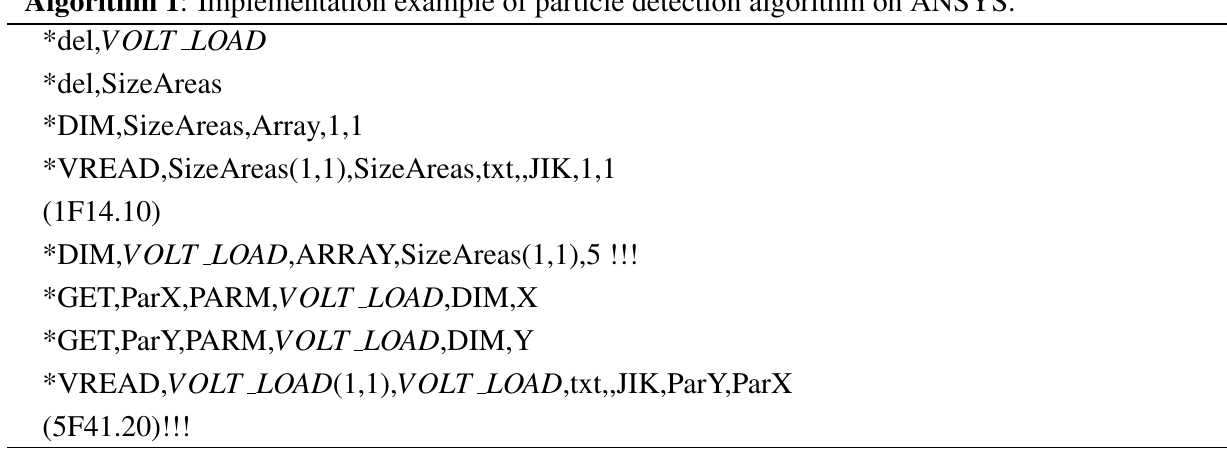
Algorithm 1 : Implementation example of particle detection algorithm on